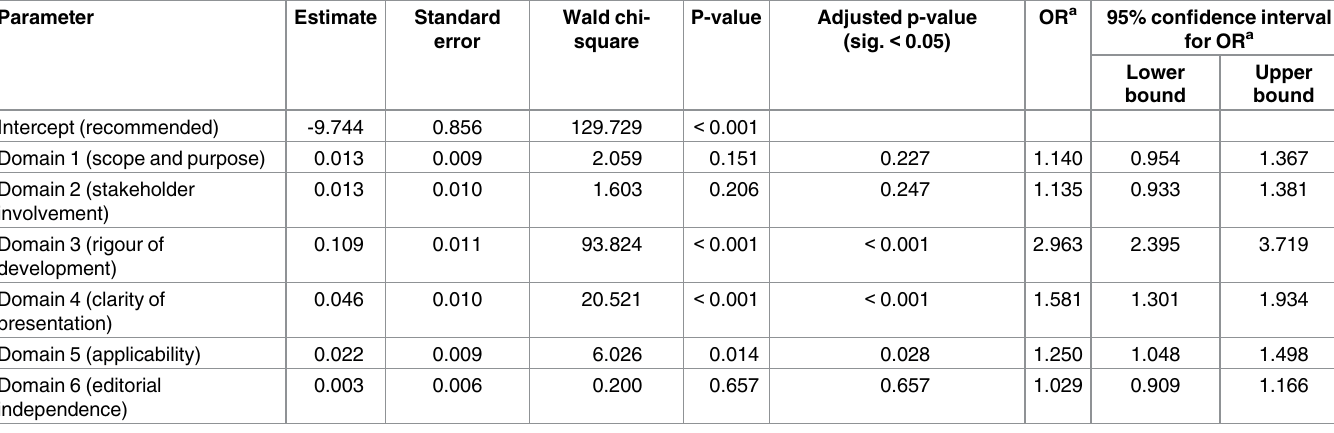
Table 3. Results of the multinomial regression analysis (independent variable: Recommendation for use for the categories “yes” vs.